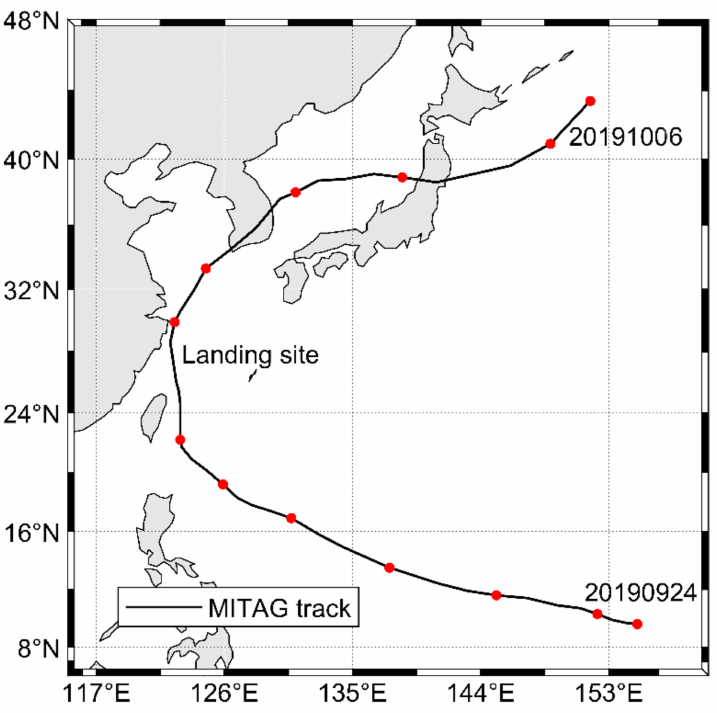
Figure 1. Track of typhoon “MITAG”. (The point is the daily time point, and the black line is the typhoon